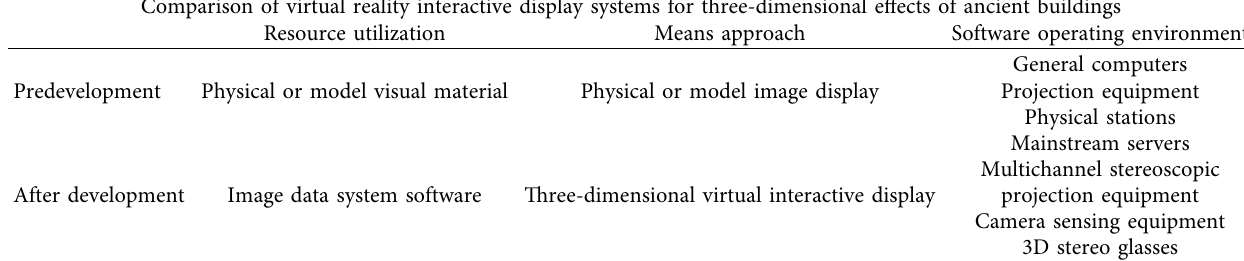
Figure 2: (a) Screenshot from the Dunhuang Mogao Grottoes 3D restoration video—red and blue technology. (b) Screenshot from the Dunhuang Mogao Grottoes 3D restoration video—polarization technology. Table 1: Virtual reality interactive display design system for building body effects in antiquity. Comparison of virtual reality interactive display systems for three-dimensional effects of ancient buildings